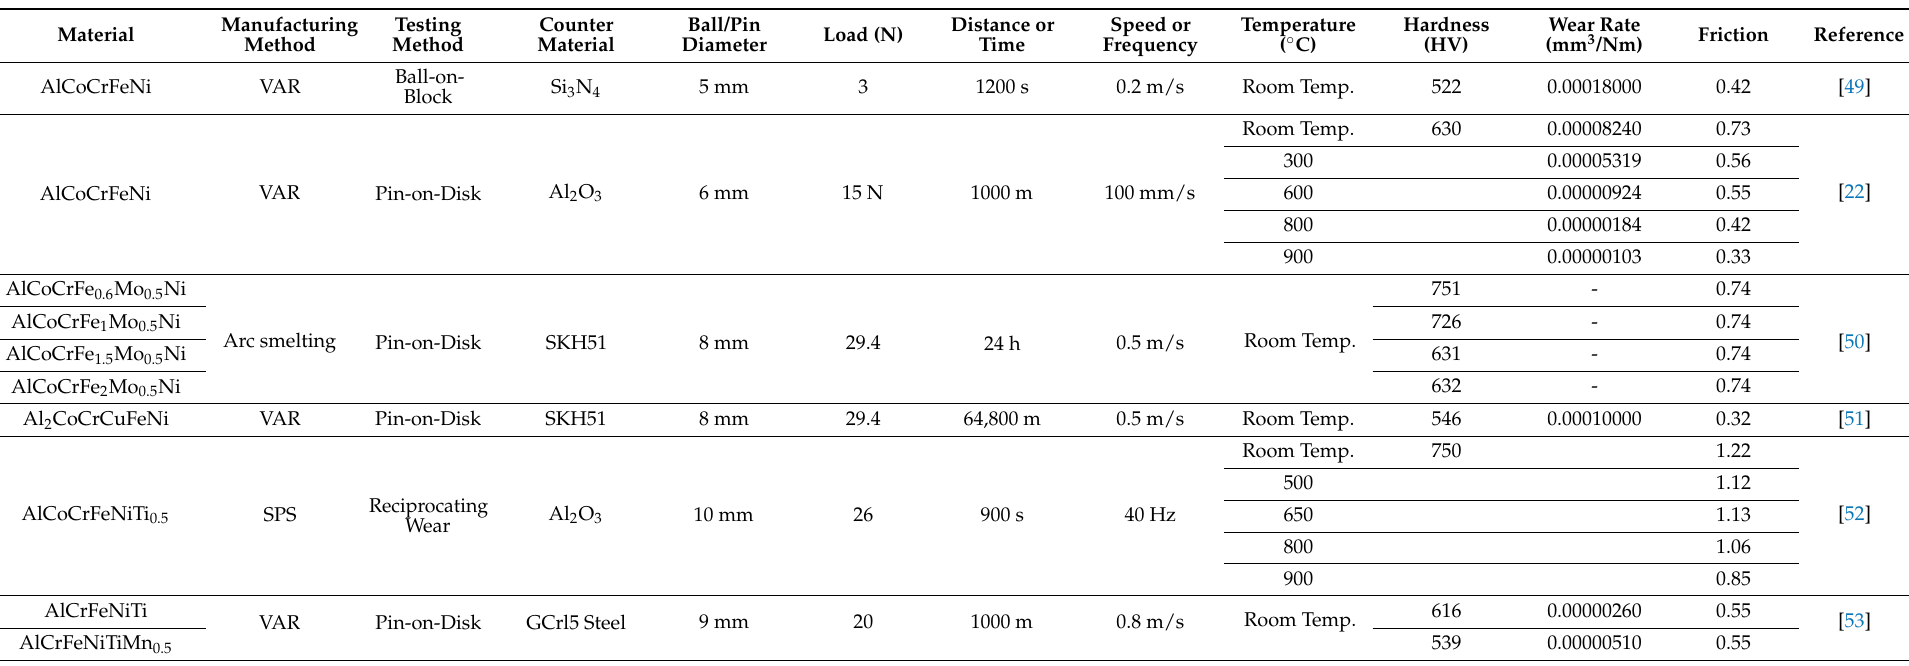
Table 1. BCC phase group test procedure information and tribological